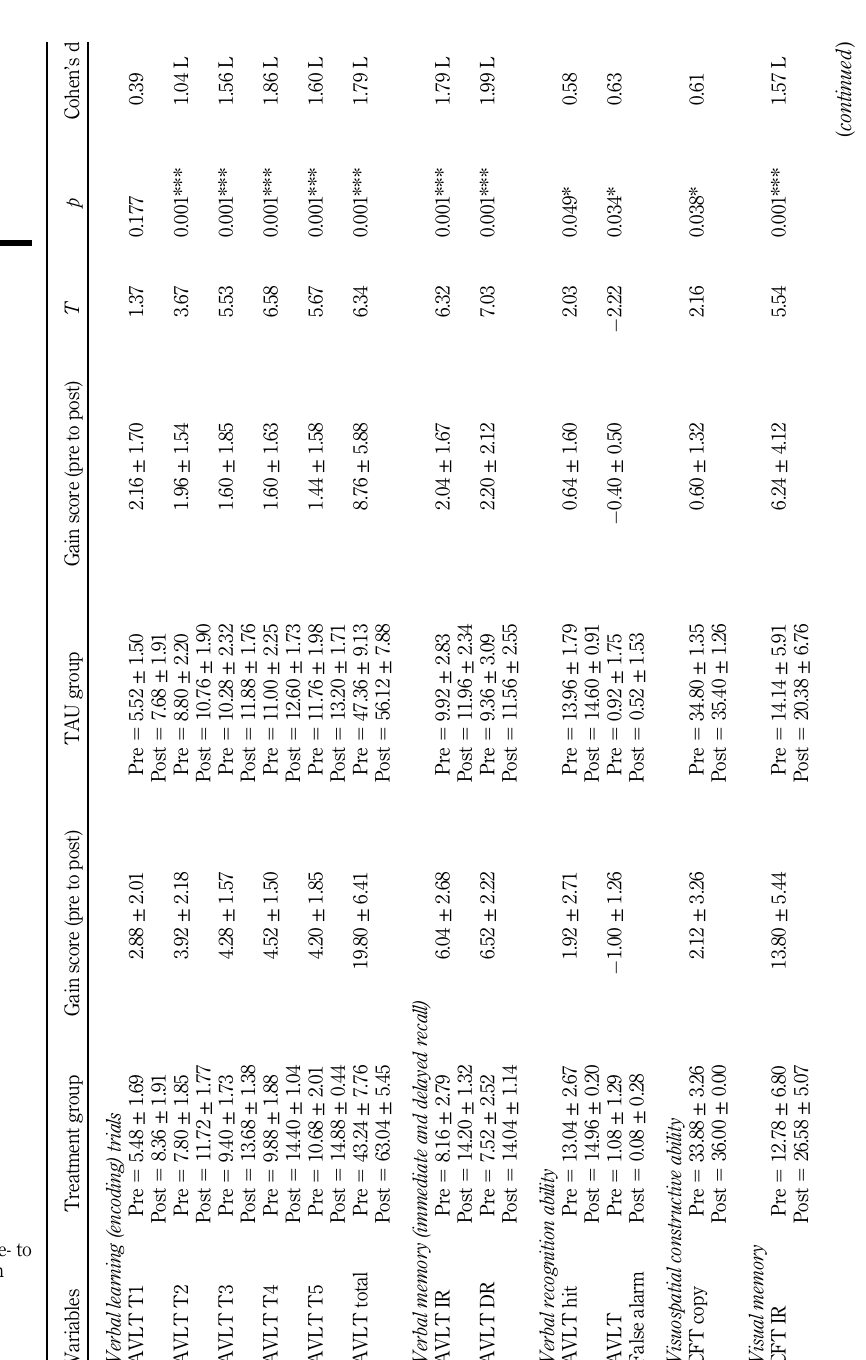
Table 2. Gain score from pre- to post-intervention in both groups and between-group change